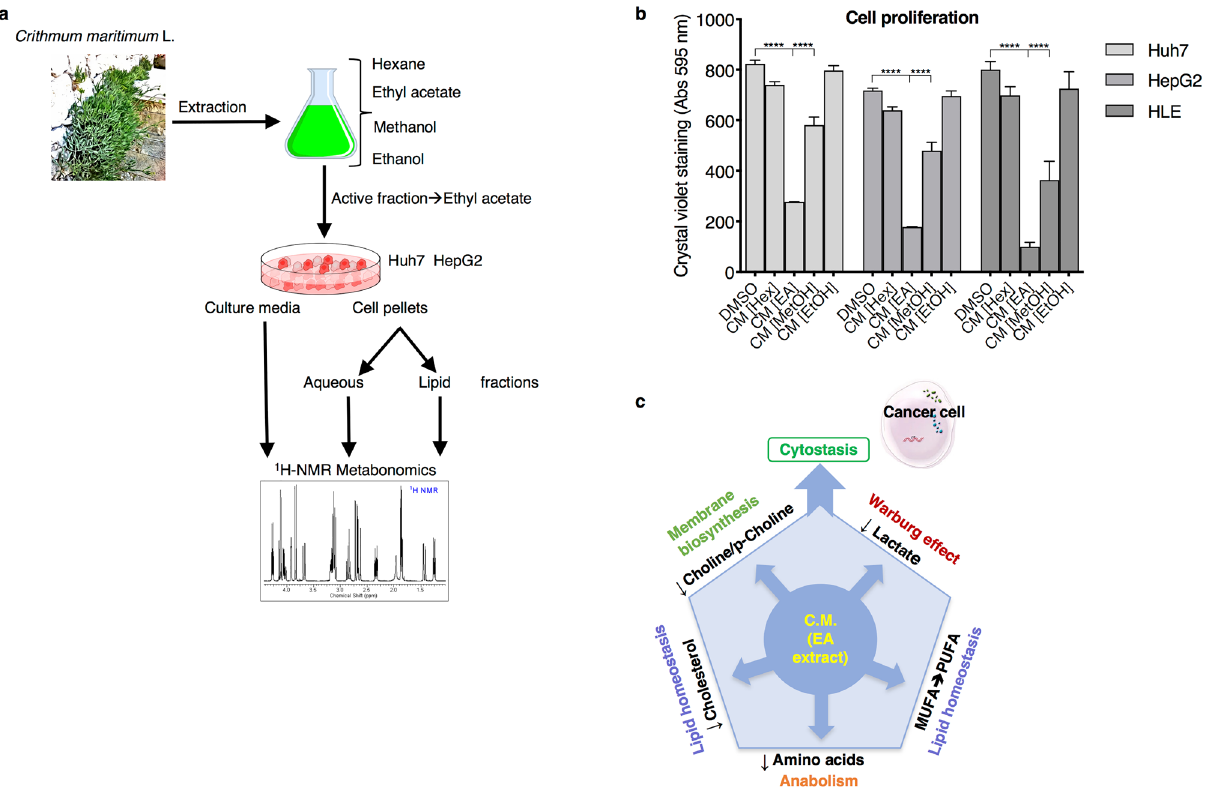
Figure 1. ( a ) Cartoon outline of the experimental workflow ( b ) Effect of the different Crithmum maritimum extracts on cell proliferation in three different HCC cell lines (Huh7, HepG2, HLE) as determined by crystal violet staining. Cells were treated for 72 h with the four different Crithmum maritimum extracts at 0.5 μM. **** p < 0.0001, *** p < 0.001 as determined by 2-way ANOVA analysis followed by Dunnett’s multiple comparisons tests. ( c ) Cartoon showing the proposed multi-target effect exerted by Crithmum maritimum ethyl acetate extract on HCC cells. DMSO Vehicle treatment, CM Crithmum maritimum treatment, [Hex] Hexane, [EA] Ethyl Acetate, [MetOH] Methanol, [EtOH] Ethanol. Results are expressed as the mean ± s.e.m. of at least three independent biological replicates, each conducted in